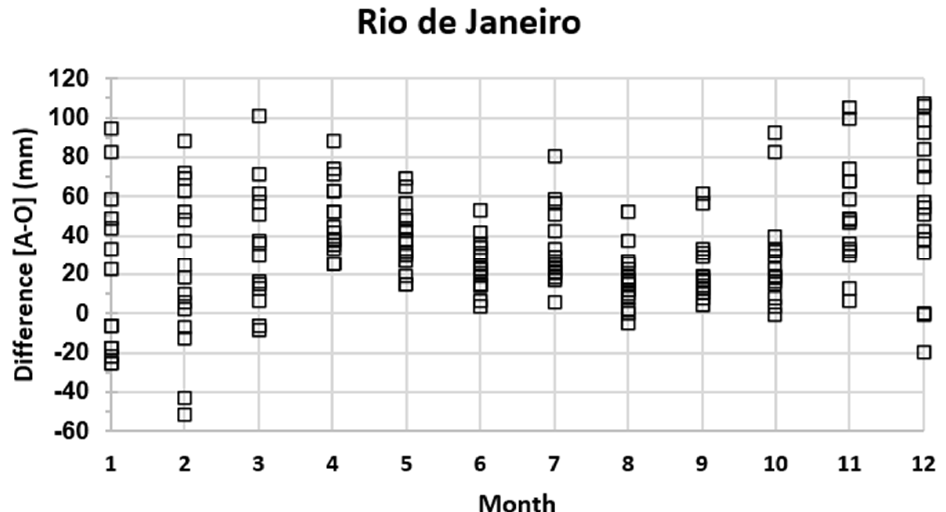
Figure 5. Monthly differences between the average monthly precipitation difference obtained with the SOAS method (A) and that estimated with CMORPH (O) for all months of the year between 2000 and 2015 for the State of Rio de Janeiro.